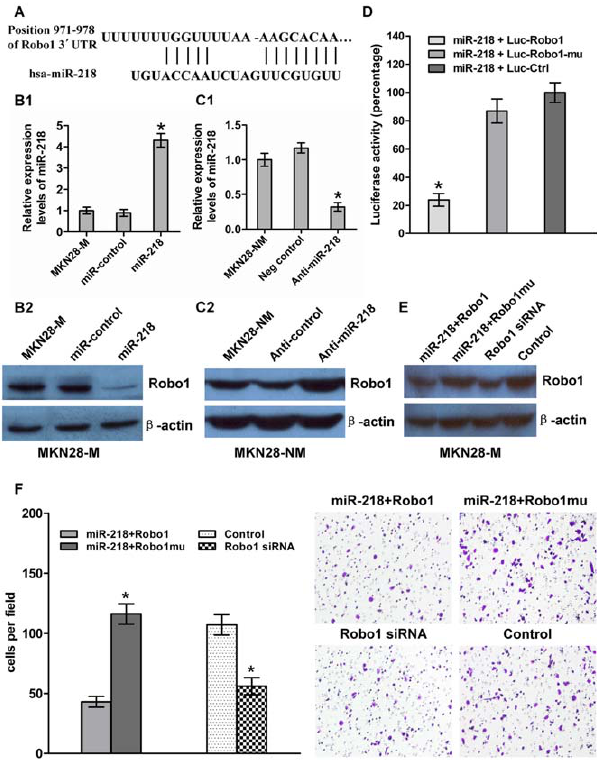
Figure 5. miR-218 targeted Robo1 by binding to its 3 9 -UTR. (A) The Robo1 3 9 -UTR was a potential target of miR-218. (B and C) miR-218 and Robo1 levels were analyzed by qRT–PCR and western blot, respectively. Robo1 levels decreased when miR-218 was upregulated in response to the miR-218-expression vector in MKN28-M cells, whereas the reverse was observed for Robo1 expression when miR- 218 was knocked down in MKN28-NM cells. (D) MKN28-M cells were co- transfected with miR-218 and a luciferase reporter (Luc-Robo1) containing a fragment of the Robo1 3 9 -UTR harboring either the miR- 218 binding site or a mutant (Luc-Robo1 - mu) in which the first six nucleotides of the miR-218 binding site were deleted. A luciferase reporter construct engineered with a non-related fragment of cDNA was used as a negative control (Luc-control). The assays showed that luciferase activity in the Luc-Robo1 group was significantly decreased compared to the luciferase activity of the mutant and negative control groups. (E) MKN28-M-miR-218 cells, which stably over-expressed miR- 218, were transiently transfected with a Robo1 expression construct or a Robo1 mutant construct lacking the miR-218 binding site. MKN28-M cells were transfected with Robo1 siRNA or a negative control siRNA. Western blot analysis for Robo1 showed that co-transfection of miR-218 and the Robo1 mutant construct produced higher levels of Robo1 protein than co-transfection of miR-218 and the Robo1 construct. Robo1 siRNA effectively reduced the amount Robo1 protein observed. (F) The cell invasion assay indicated that Robo1 mutant constructs could reverse the effect of miR-218-mediated suppression of cell invasion. Knockdown of Robo1 by siRNA in MKN28-M cells inhibited cell invasion. * P , 0.05.